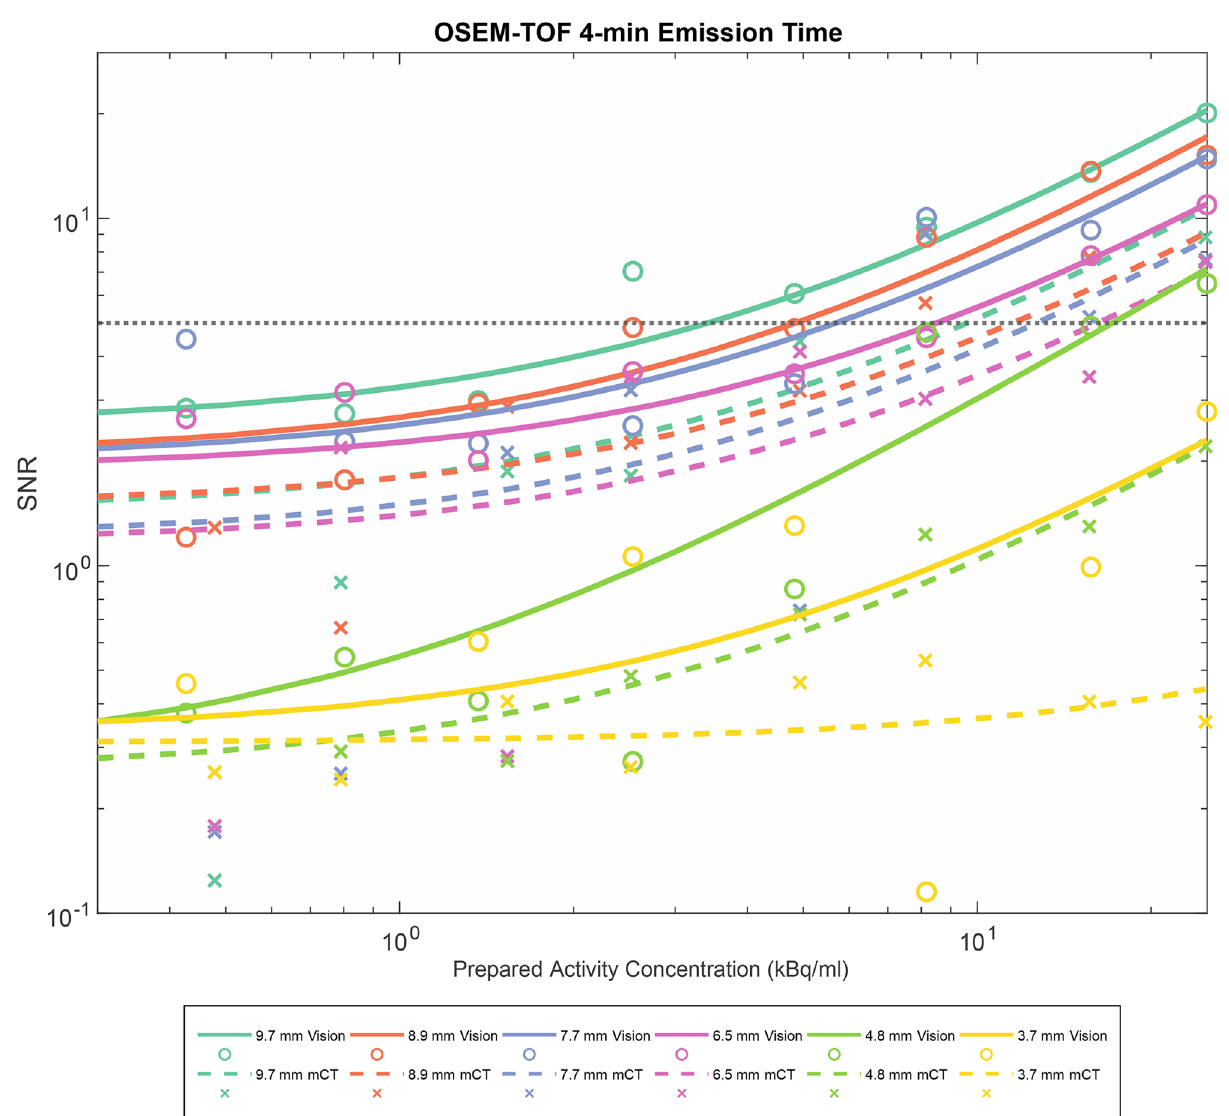
Figure 3. SNR as a function of the AC for all evaluated spheres for a clinical standard emission protocol (OSEM-TOF, 4-min emission time). A horizontal line at SNR = 5 indicates the threshold for visual detectability in OSEM-TOF reconstructed